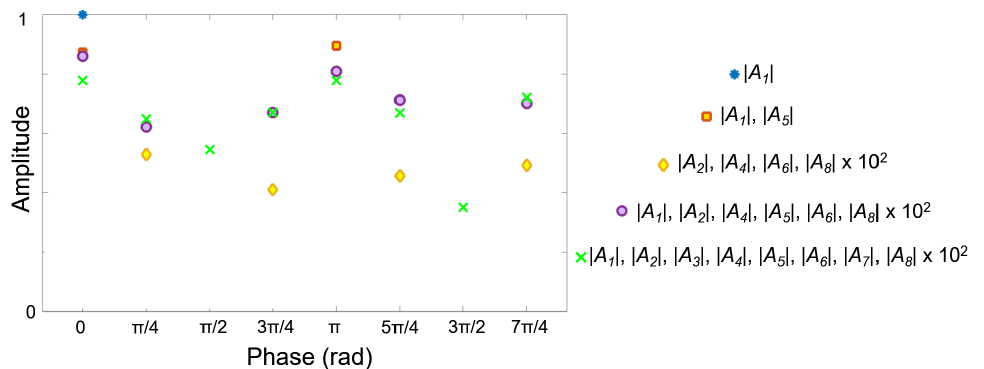
Figure 2. Module and phase of the optimized incident plane waves. For the sake of clarity, for the cases of i = 2, 4, 6, 8, the modules of the coefficients are normalized to the maximum of the whole set of coefficients.